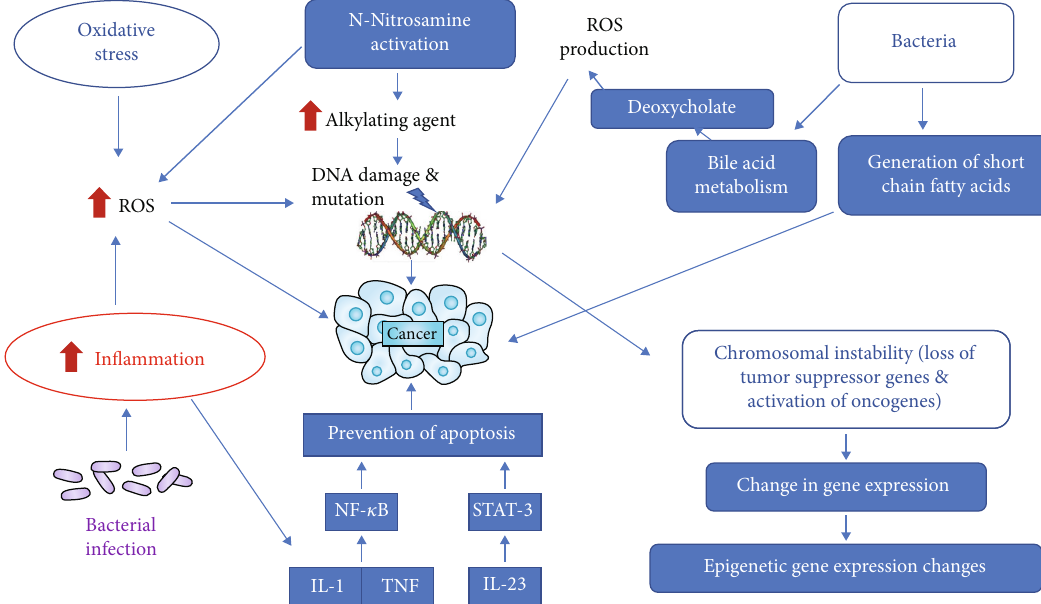
Figure 1: Di ff erent molecular mechanisms of carcinogenesis induced by bacterial infection and oxidative